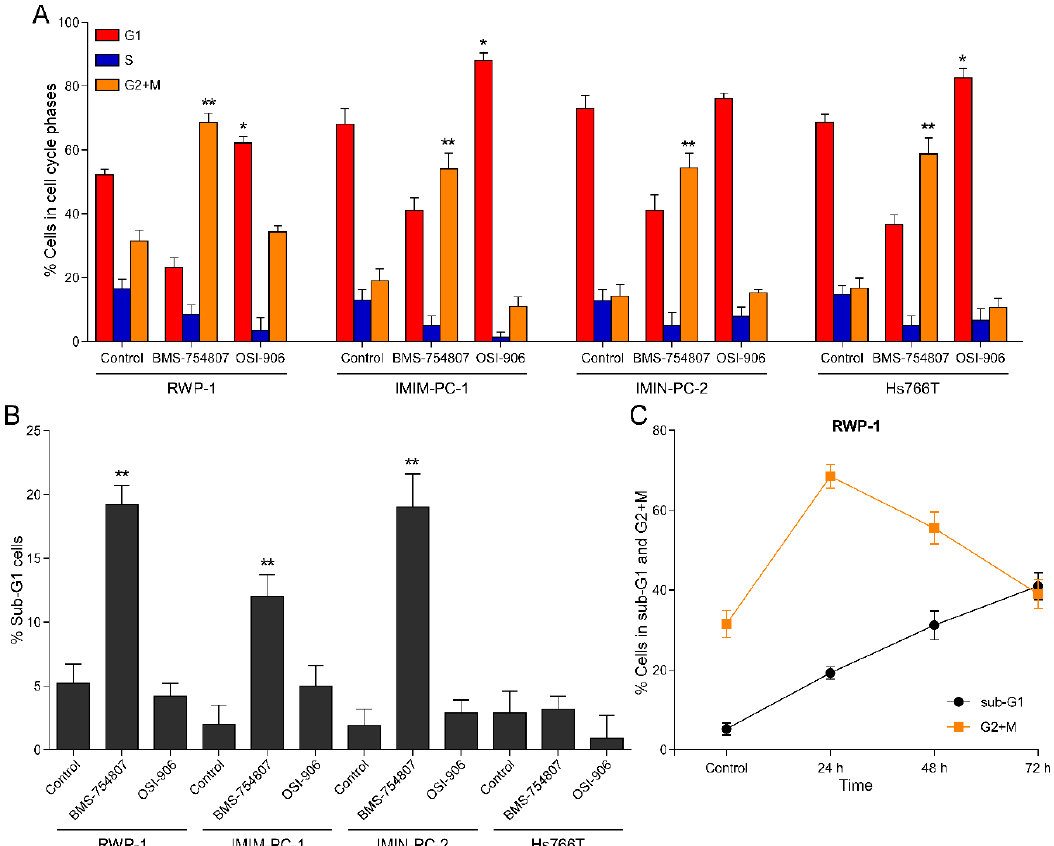
Figure 4. ( A ) Effect of BMS-754807 and OSI-906 on cell cycle phase distribution in pancreatic carcinoma cell lines. RWP-1, IMIM-PC-1, IMIM-PC-2 and HS766T cell lines were treated with 10 µM BMS-754807 or OSI-906 for 24 h and cell cycle phase distribution was analyzed by flow cytometry. Data represent the mean ± SEM ( n ≥ 3) of the percentage of cells in each phase of the cell cycle. * p < 0.05, ** p < 0.01. ( B ) Cell death induction by BMS-754807 and OSI-906 in pancreatic carcinoma cell lines. RWP-1, IMIM-PC-1, IMIM-PC-2 and HS766T were treated with 10 BMS-754807 µM or OSI-906 for 24 h. Data represent the mean ± SEM ( n ≥ 3) of the percentage of dead cells (sub-G1) on the cell cycle analysis represented in A. ** p < 0.01. ( C ) Effect of 10 µM BMS-754807 for 24, 48 and 72 h in the pancreatic carcinoma cell line RWP-1. Data represent the increase in the percentage of cell death and the parallel decrease in cells in the G2 + M phase of the cell cycle. Data represent the mean ± SEM ( n ≥ 3).